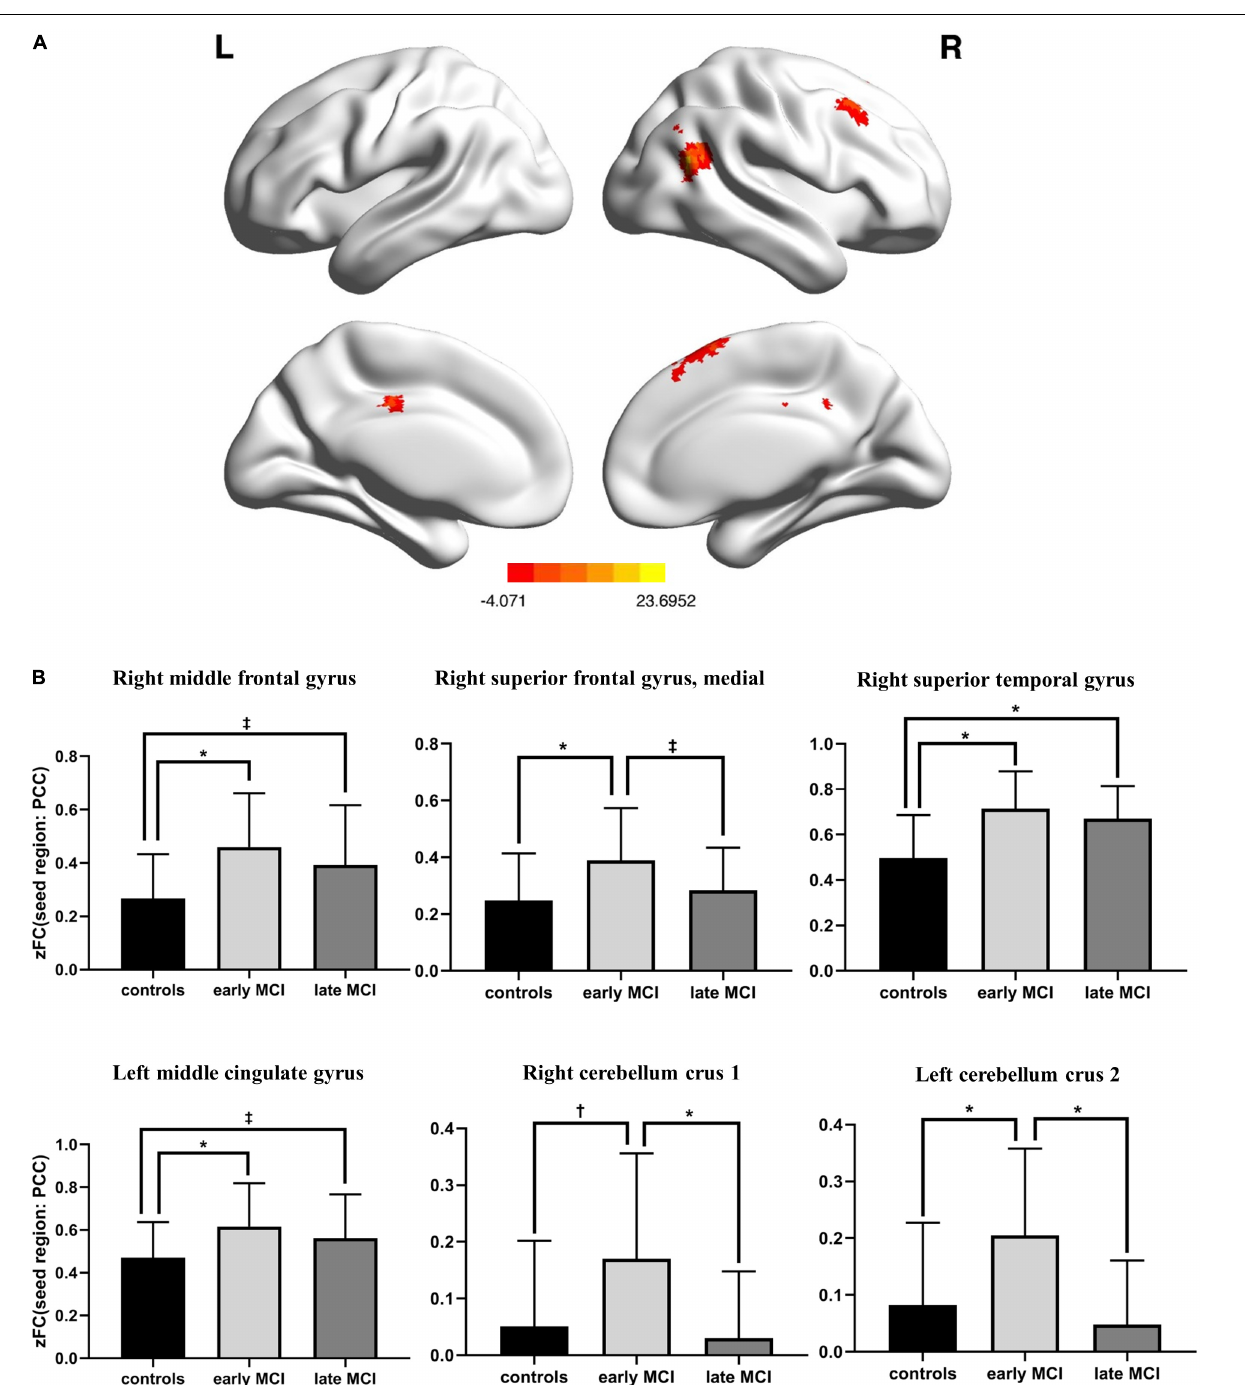
FIGURE 1 | (A) Brain regions where the functional connectivity of the posterior cingulate cortex showed significant differences among control subjects, early-mild cognitive impairment (MCI) patients, and late-MCI patients (ANCOVA, Monte Carlo simulation-corrected p < 0.01). (B) Difference in functional connectivity from the posterior cingulate cortex among control subjects, early-MCI patients, and late-MCI patients (Bonferroni post hoc tests). ∗ Bonferroni-corrected P < 0.001; † Bonferroni-corrected P < 0.01; ‡ Bonferroni-corrected P < 0.05.